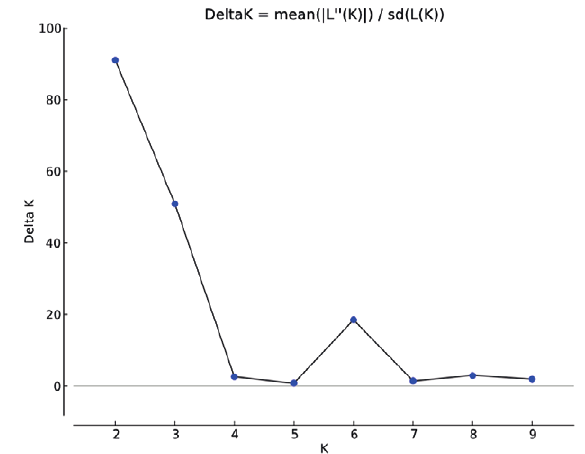
Figure 5. Delta k plot of Evanno’s test based on STRUCTURE anal-